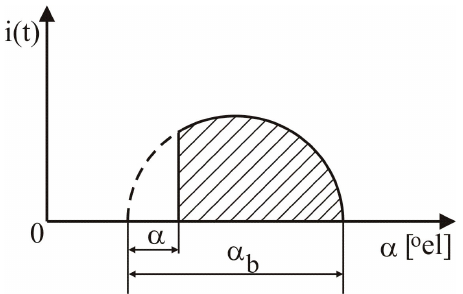
Figure 1. The definition of the firing angle ( α ) and the locking angle ( α b ).